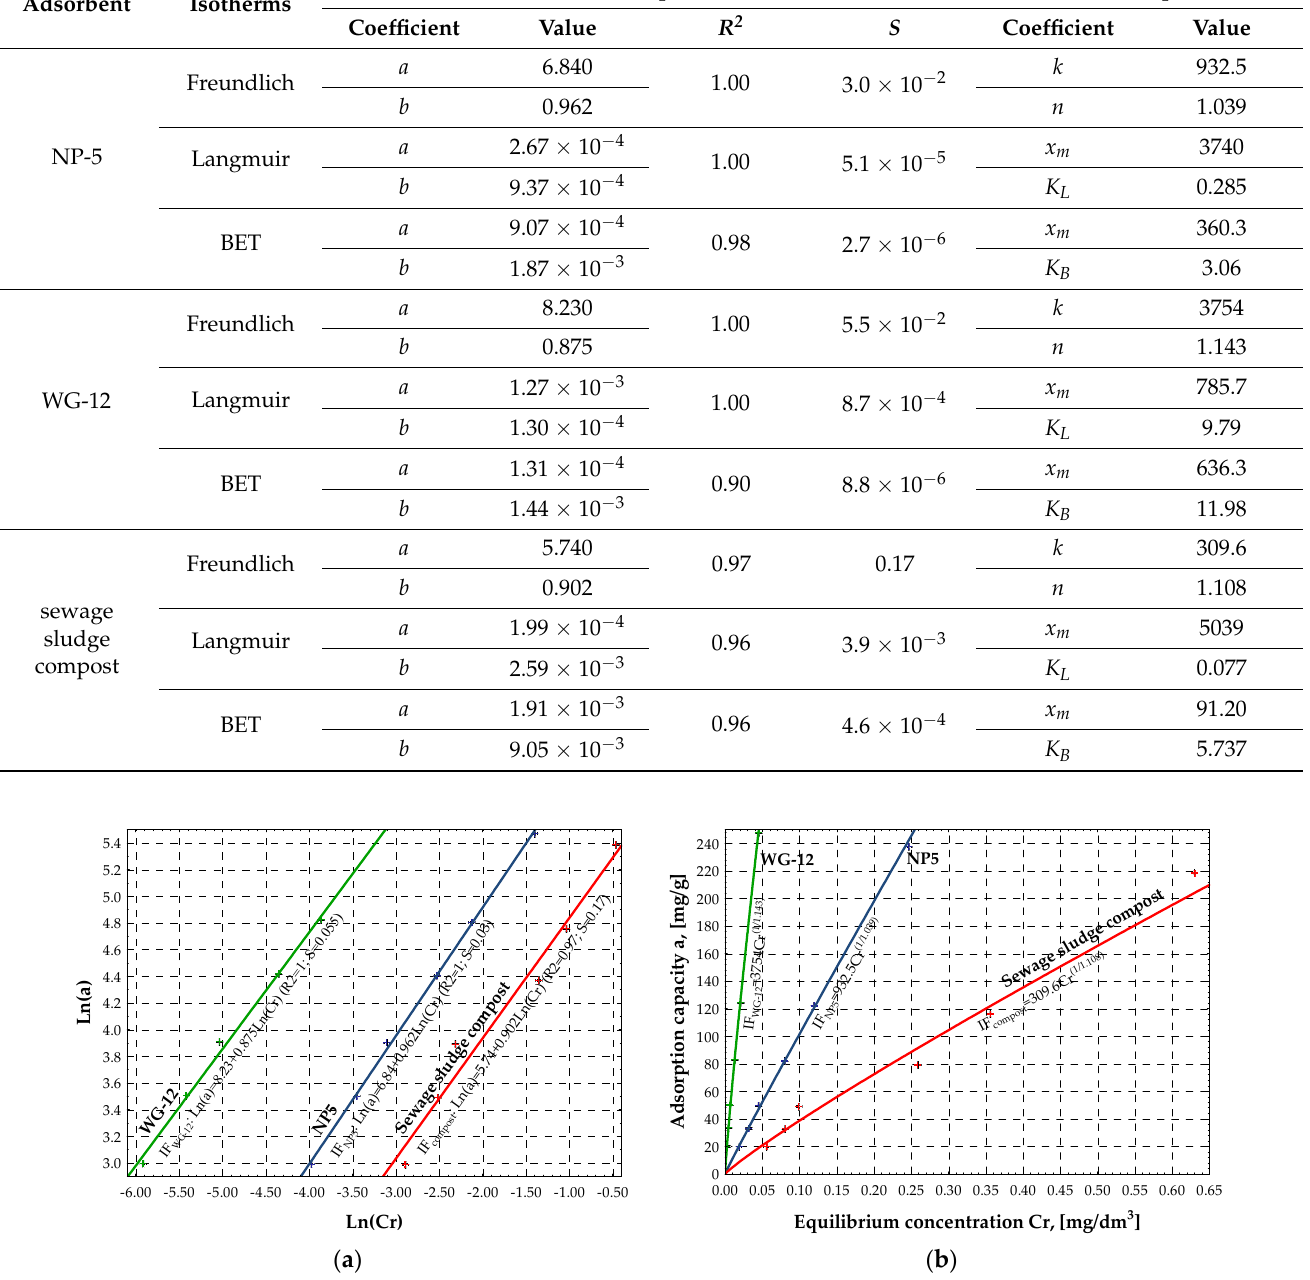
Figure 2. Graphs of linear isotherms ( a ) and classic isotherms ( b ) according to Freundlich for tested sorbents.